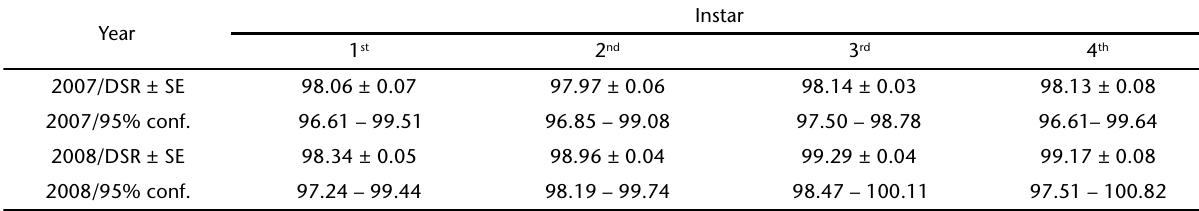
Table II. Daily survival rates (DSR), with SE, and 95% confidence intervals, o f P. papiu s caterpillars at the Yanayacu Biological Station,